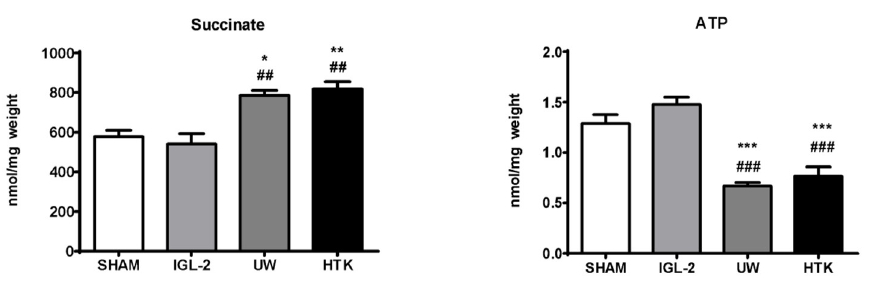
Figure 3. Succinate accumulation and ATP breakdown in fatty livers preserved in IGL-2, UW, and HTK solutions (24 h; 4 °C). The bars represent the mean values ± SEM of each group (n = 4–6). Differences are shown comparing groups (* vs. Sham, # vs. IGL-2) according to the one-way ANOVA test and the Tukey post-hoc test (one symbol indicates p < 0.05; two symbols indicate p < 0.01; three symbols indicate p < 0.001).